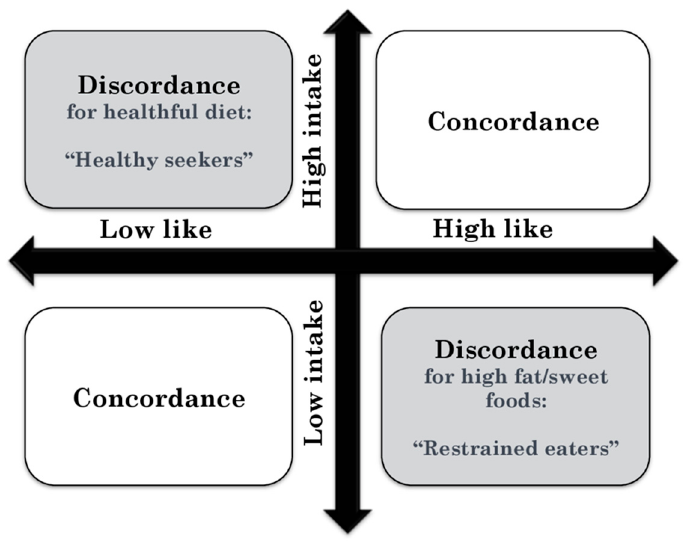
Figure 1. Conceptual model of agreement/disagreement in reported of liking and intake of a healthy diet (diet quality indexes) and high fat/sweet foods with high liking and low intake as an indirect measure of dietary